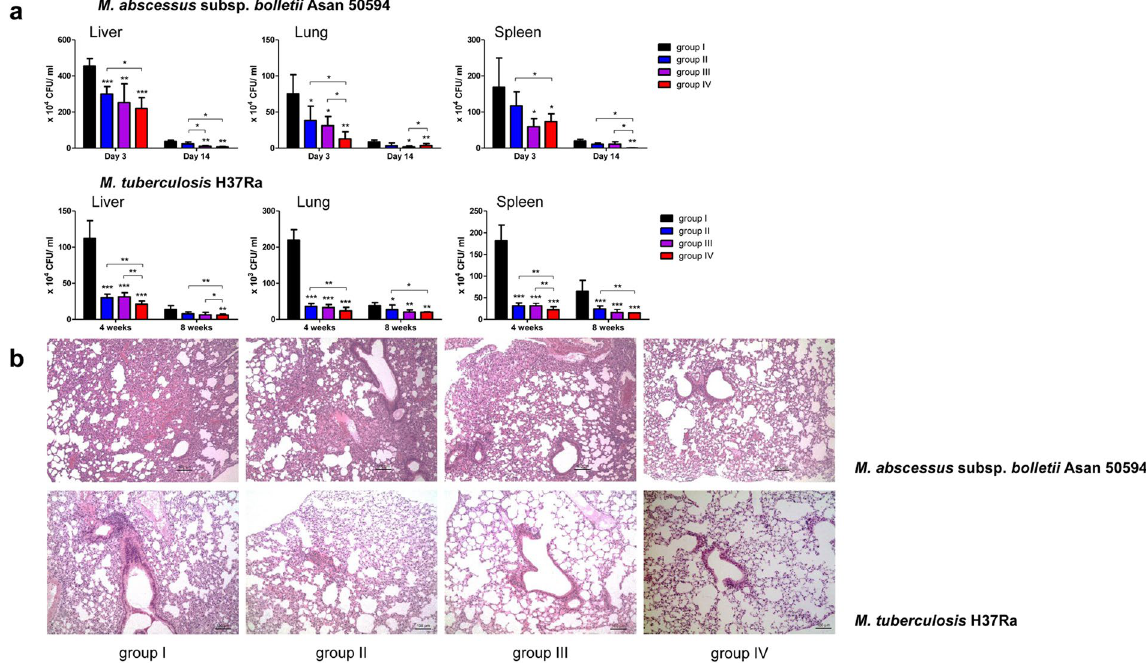
Figure 8. M. paragordonae (Mpg) vaccine elicited an enhanced protective efficacy against M. abscessus or M. tuberculosis infections in a mouse model. ( a ) CFU enumeration from organs (liver, lung and spleen) of BALB/c mice (n = 4–6 per group) vaccinated subcutaneously with PBS, BCG (1 × 10 6 CFU) or Mpg (1 × 10 6 CFU) (vaccination groups are detailed in Supplementary Fig. 2) and challenged 4 weeks after final vaccination with Mab or Mtb (1 × 10 6 CFU, intravenously) ( * P < b 0.05, ** P < 0.01, *** P < 0.001; Student’s t -test). ( b ) Representative histopathologic images (H&E stained) are shown for the sectioned lung tissues of BALB/c mice vaccinated with PBS, BCG or Mpg (vaccination groups are detailed in Supplementary Fig. 2) and challenged with Mab (at Day 14) or Mtb (at Week 8). Scale bars correspond to 100 μ m. Each vaccinated group is annotated as follows: group I [PBS + PBS], group II [BCG + BCG], group III [BCG + Mpg], and group IV [Mpg +